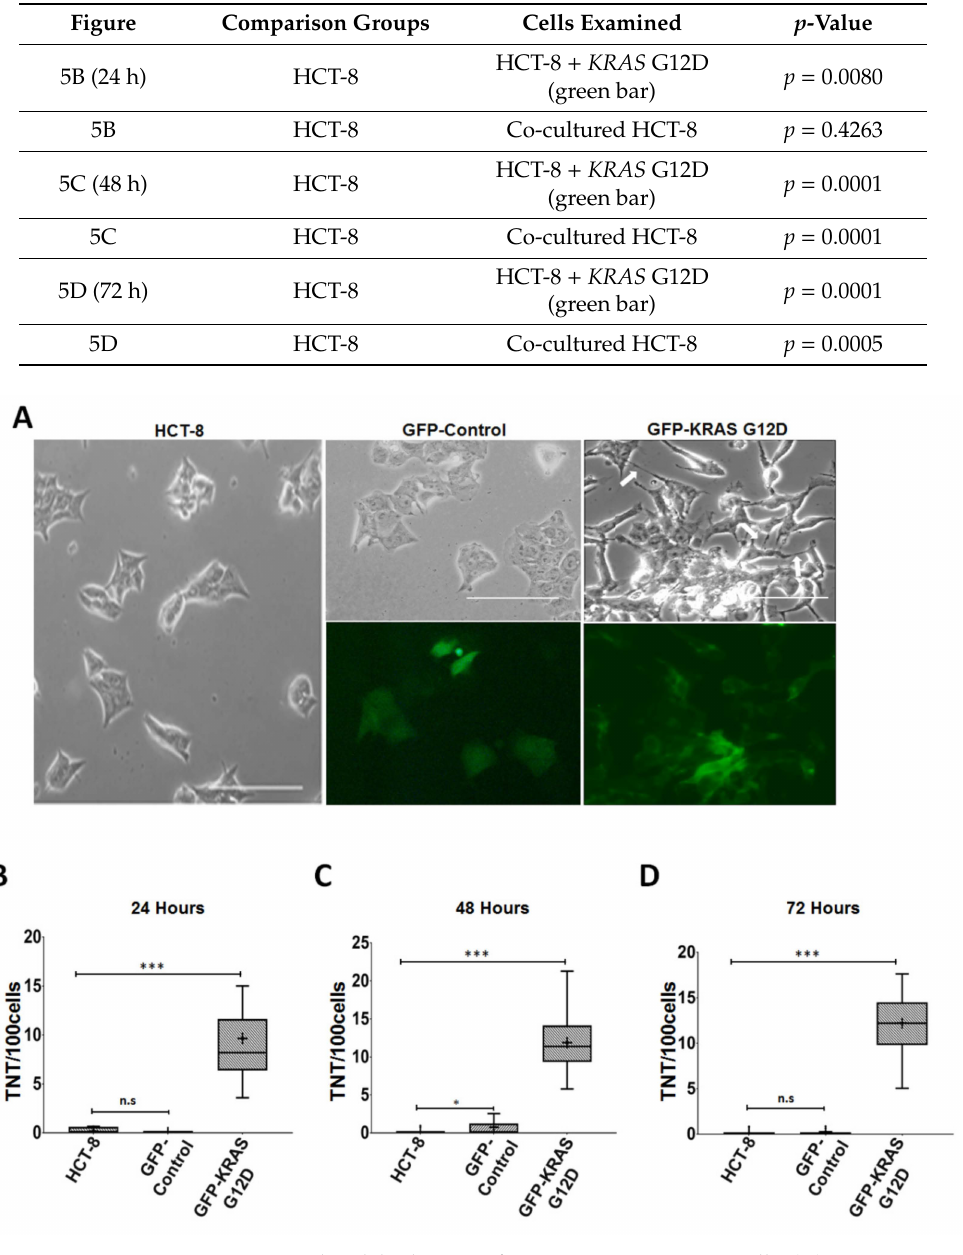
Figure 6. Mutant KRAS is associated with higher TNT formation among HCT-8 cells. ( A ) Representative phase contrast and fluorescence microscopy images of HCT-8 cells, HCT-8 cells transfected with GFP-control plasmid, and HCT-8 cells transfected with GFP- KRAS G12D mutant. ( B – D ) Boxplot representation of TNTs per 100 cells over ( B ) 24 h, ( C ) 48 h, and ( D ) 72 h. Quantification of TNTs was performed using methods similar to Figure 1. Symbols on the boxplot are as follows: Box, 1st to 3rd (Q1–Q3) Quartiles; + = Mean; Line inside box = Median. Asterisk symbol indicates statistical di ff erences in median value; n.s = non statistically